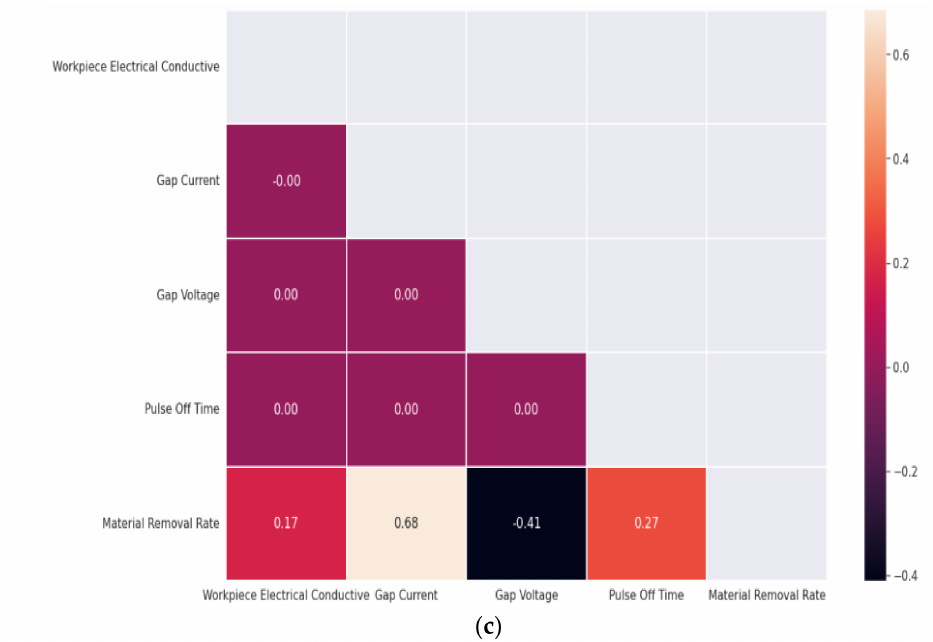
Figure 1. ( a ) Implementation of Machine Learning algorithms on the dataset; ( b ) Feature Importance Plot; ( c ) Heatmap representation.